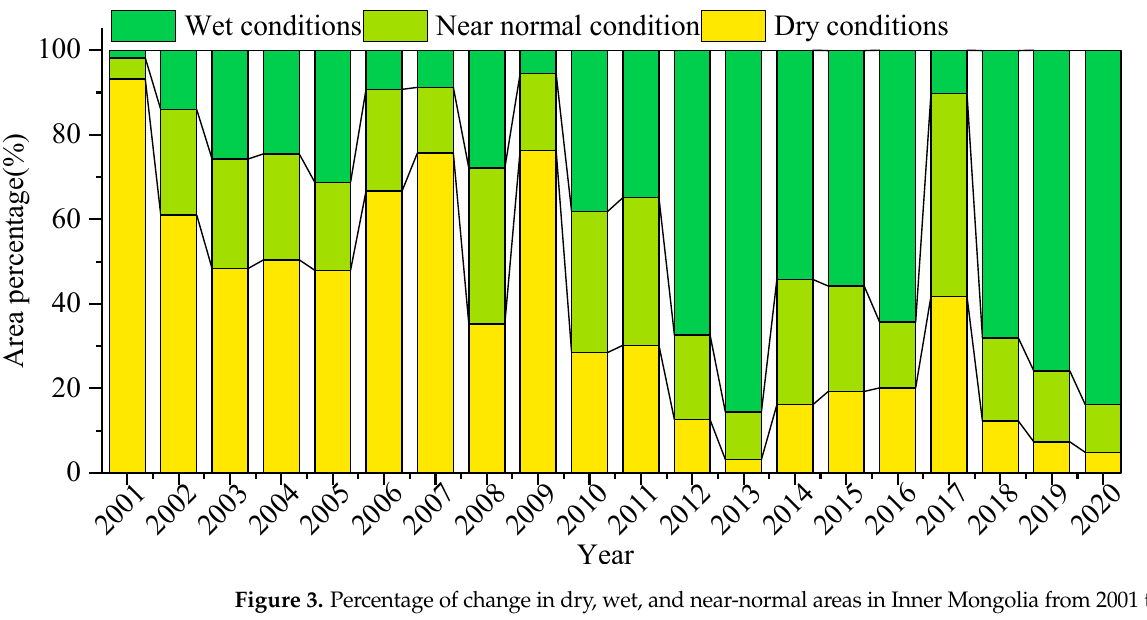
Figure 2. Trends in Inner Mongolia’s DSI index from 2001 to 2020: spatial DSI patterns ( a ); wetting and drying trends ( b ).